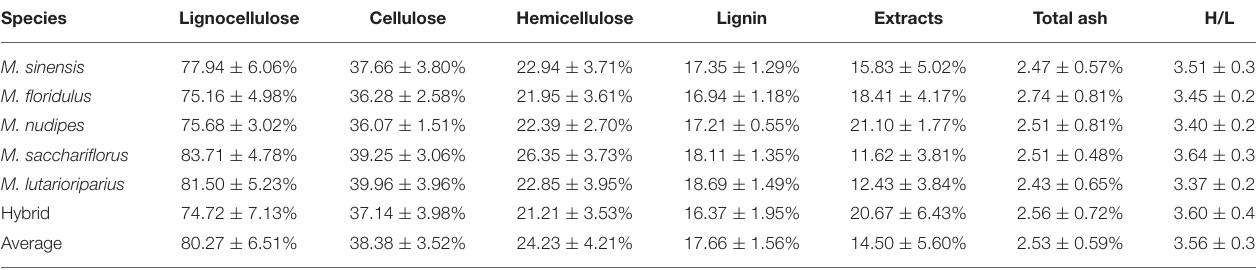
TABLE 1 | Statistics on lignocellulose content of Miscanthus .